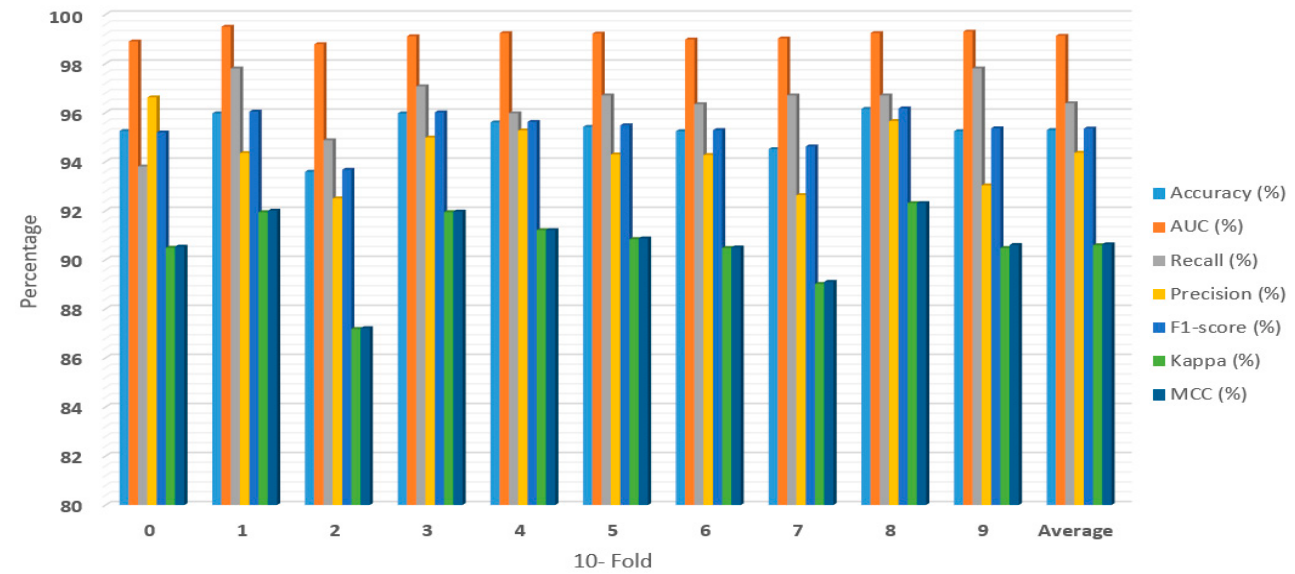
Figure 3. The metrics of the XGBoost model before hyper-parameters tuning.